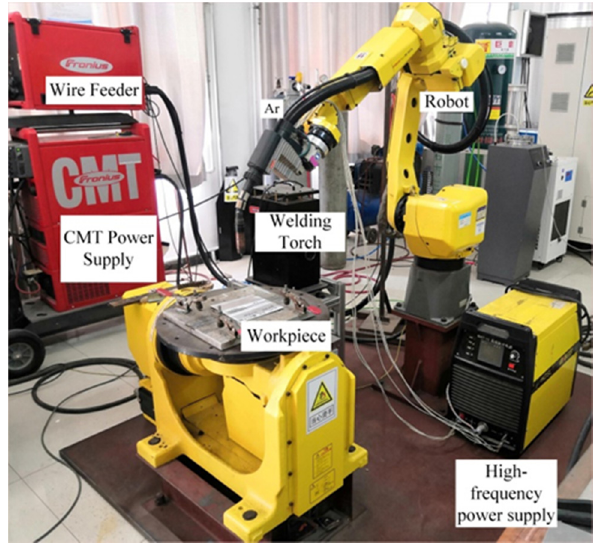
Figure 3: Photograph of the welding